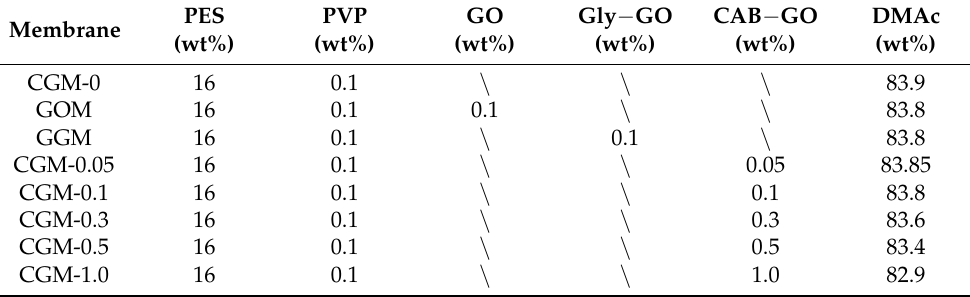
Table 1. The configuration ratio of mixed matrix